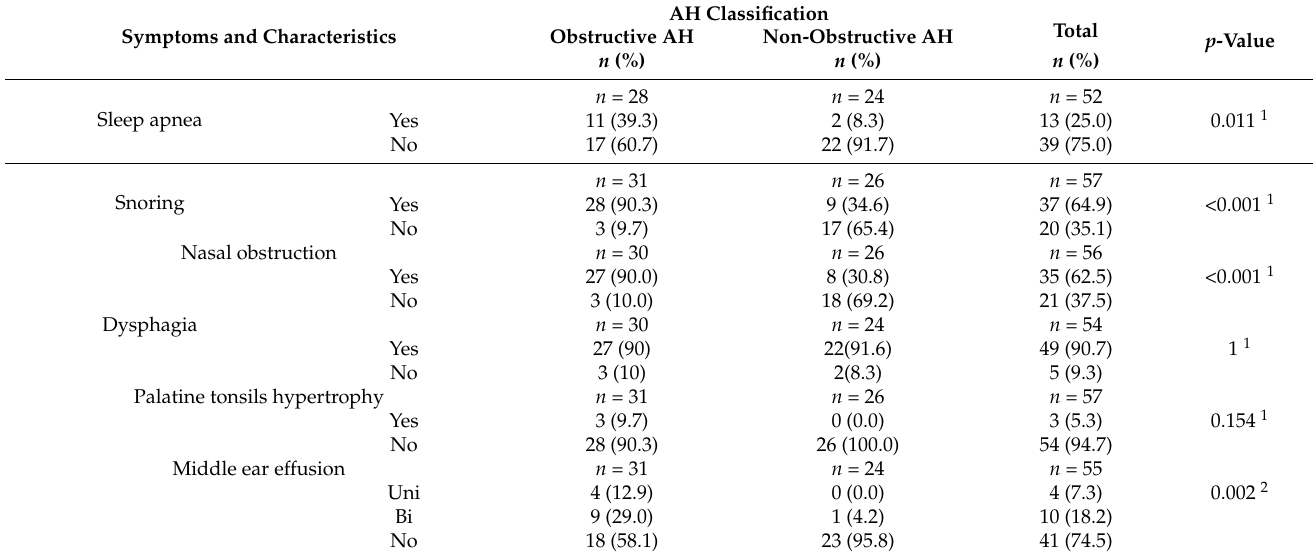
Table 2. Selected symptoms by AH status of infants with Zika-related microcephaly ( N = 57). Symptoms and Characteristics